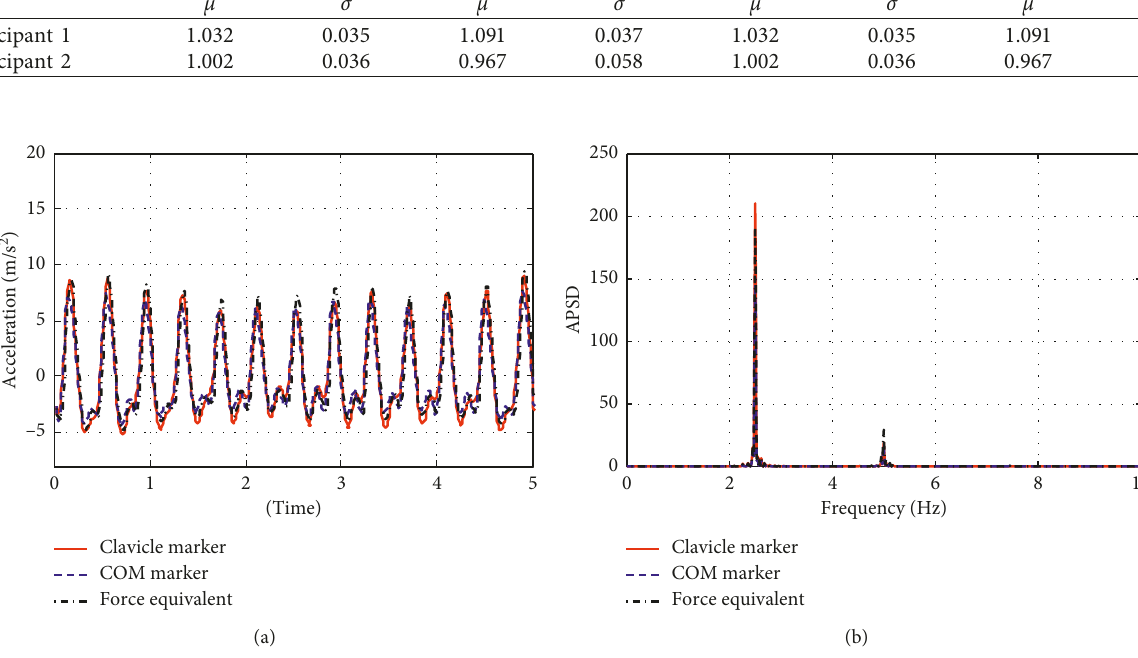
Table 1: Mean values and standard deviation of the ratio of peaks of the clavicle acceleration and the equivalent acceleration (—). Frequency (Hz)